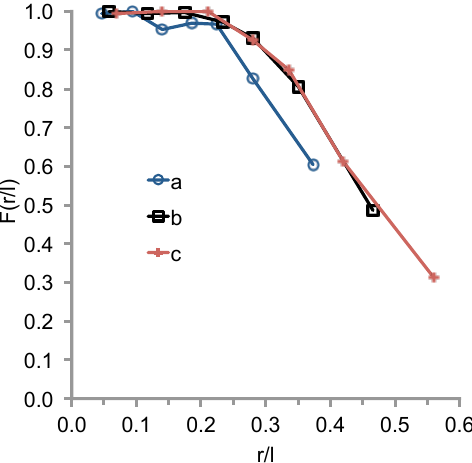
Figure 10. Correction factor F ( r /l ) vs. relative cut length r /l . Correction factor F ( r /l ) from Eq. (5) for three profiles from Fig. 8. of a 1 m PST, cut lengths > 20 cm will be subjected to in- creased stress from the far